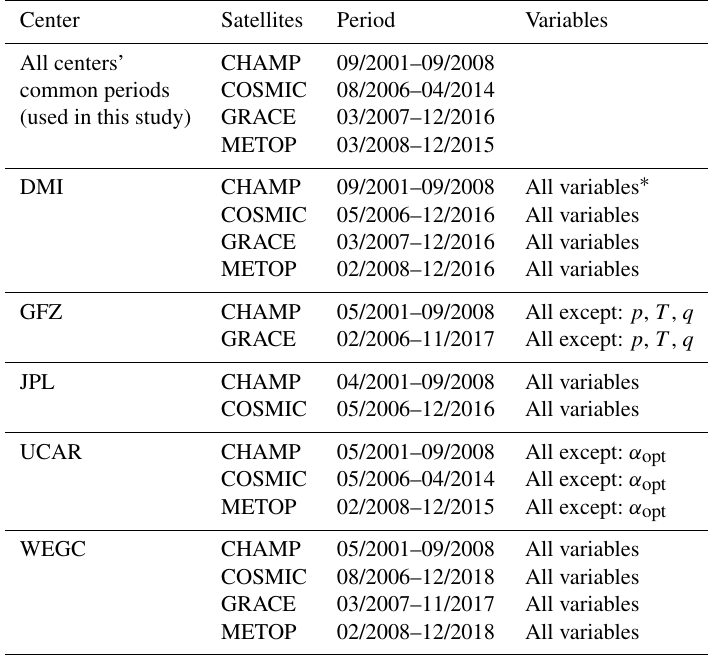
Table 2. Overview of RO data delivered by the different processing centers and the common time periods used in this study: processing center, satellite mission, time period, and variables. Center Satellites Period Variables All centers’ CHAMP 09/2001–09/2008 common periods COSMIC 08/2006–04/2014 (used in this study) GRACE